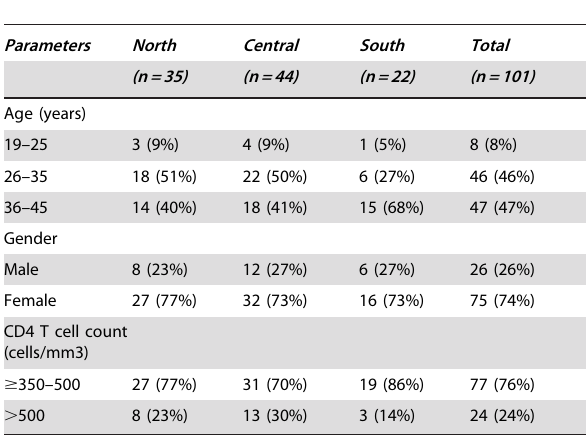
Table 1. Epidemiological and clinical characteristics of the Angolan HIV-infected patients from the different geographic